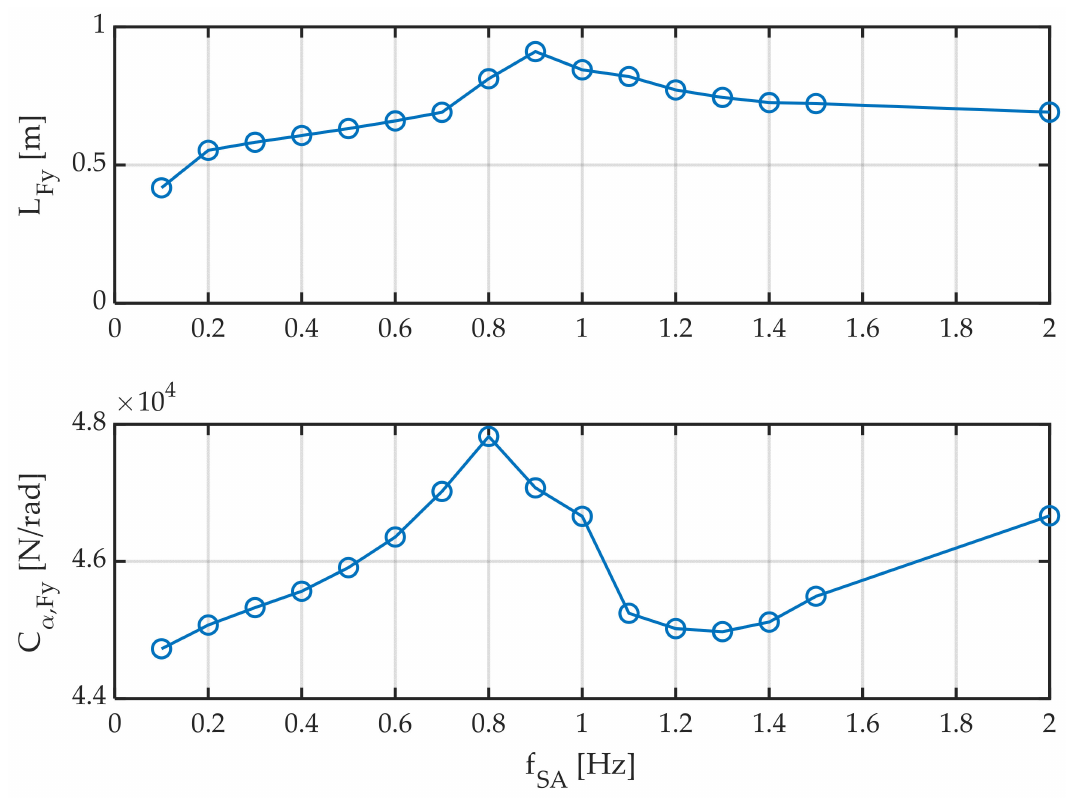
Figure 11. Relaxation length and cornering stiffness for different slip-angle sweep frequencies. Amplitude ± 2 ◦ . Longitudinal speed 60 km/h. Vertical load 4000 N. Tire temperature 60 °C.